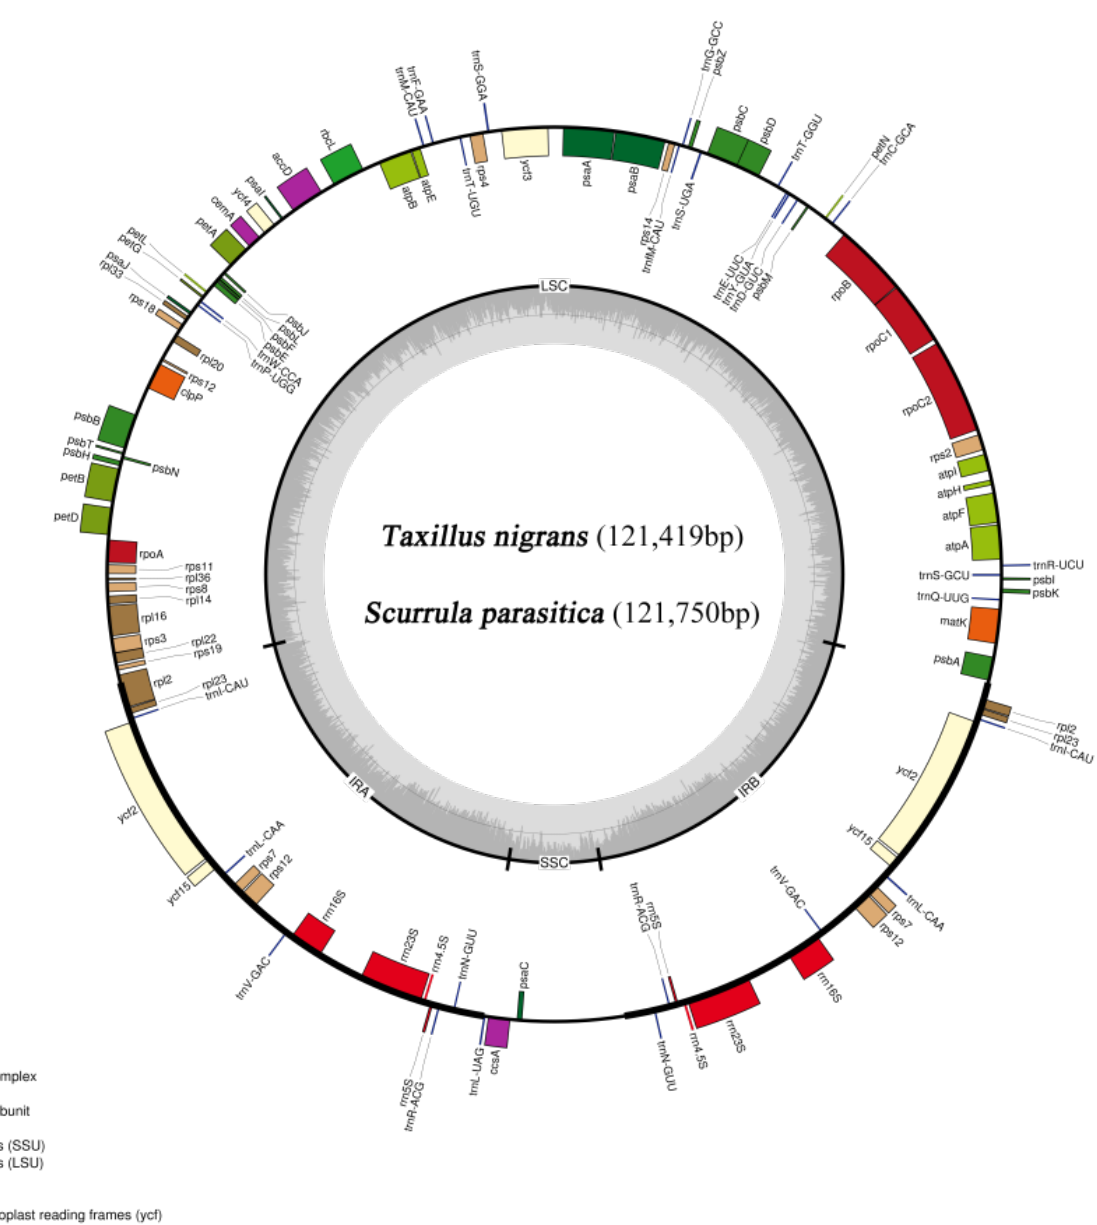
Figure 1. Gene map of T. nigrans and S. parasitica chloroplast genome (the darker gray in the inner circle corresponds to GC content, while the lighter gray corresponds to AT content).